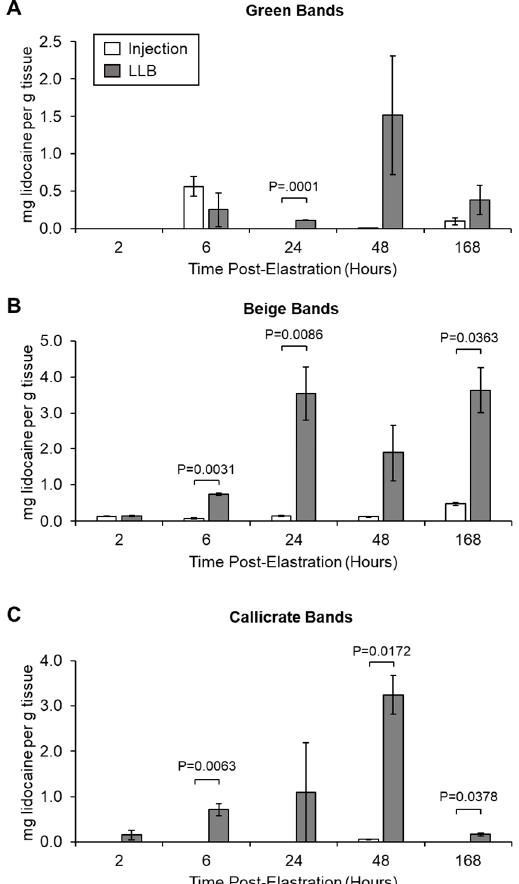
Figure 5. Lidocaine concentrations from scrotal biopsy samples collected over time. Time indicates the duration the band was on the animal prior to biopsy. Biopsies from animals treated with green ( A ), beige ( B ), or Callicrate TM ( C ) bands (LLB), or their corresponding controls (lidocaine injection), were homogenized, extracted, and the lidocaine content measured by HPLC. Bars represent the mean ± standard error of the mean (SEM) for three independent replicates per time